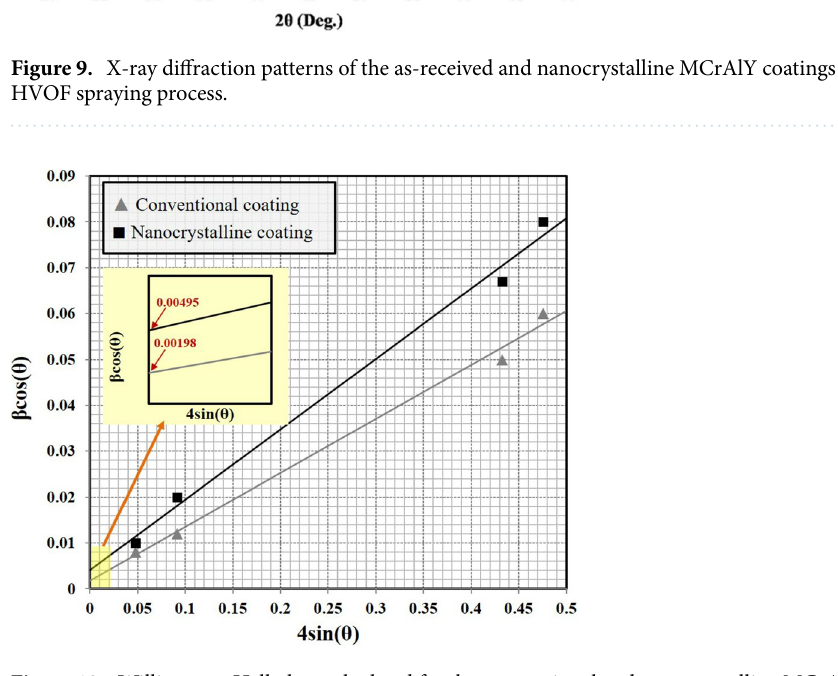
Figure 10. Williamson–Hall plots calculated for the conventional and nanocrystalline MCrAlY coatings deposited by the HVOF spraying